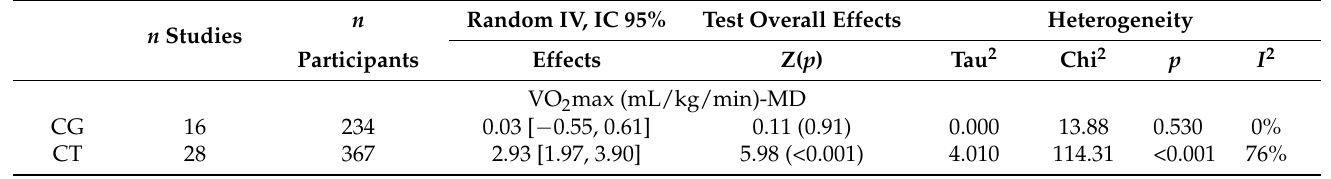
Table 3. Effect of resistance circuit training and endurance training on endurance